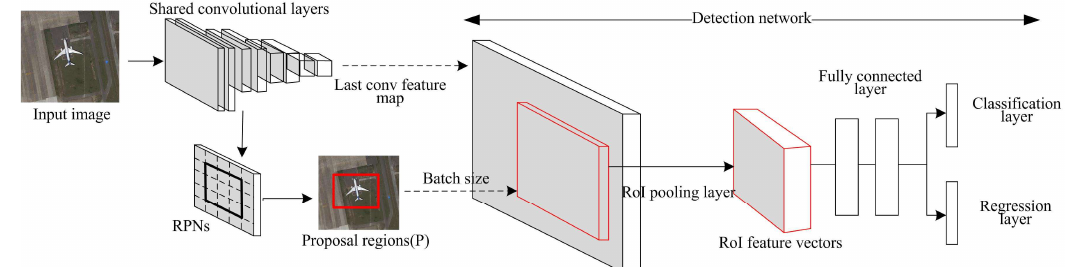
Figure 1. Faster R-CNN architecture.